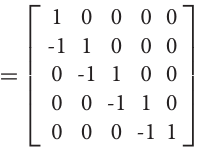
FIGURE 3 | Cost function for ¯ P s